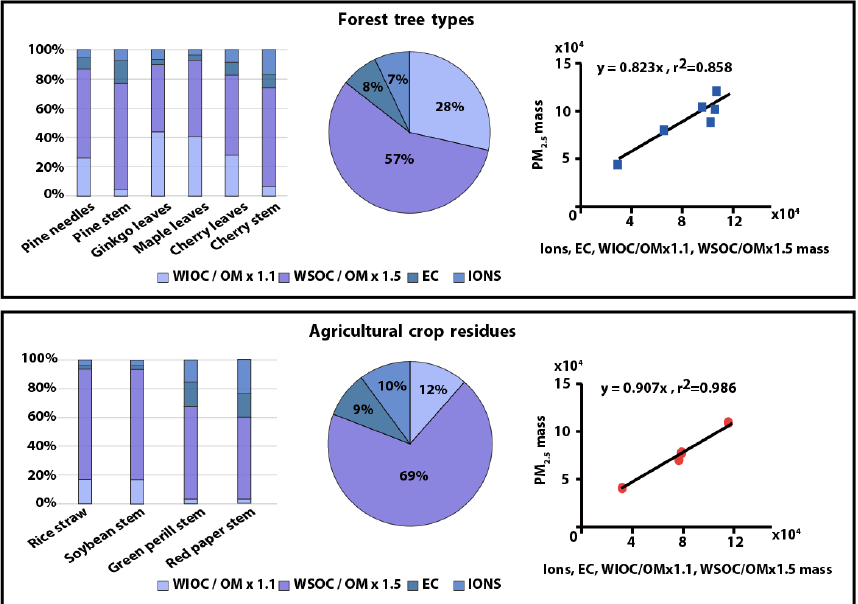
Figure 2. Relative chemical abundances in PM 2.5 and scatterplots between measured and reconstructed PM 2.5 mass from burning of forest tree types and agricultural crop residues byproducts.